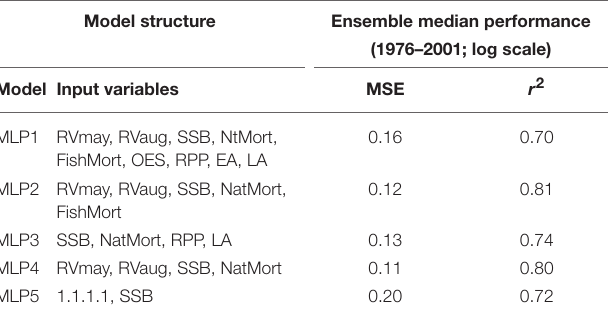
TABLE 2 | Different model structures and their recorded performance. Model